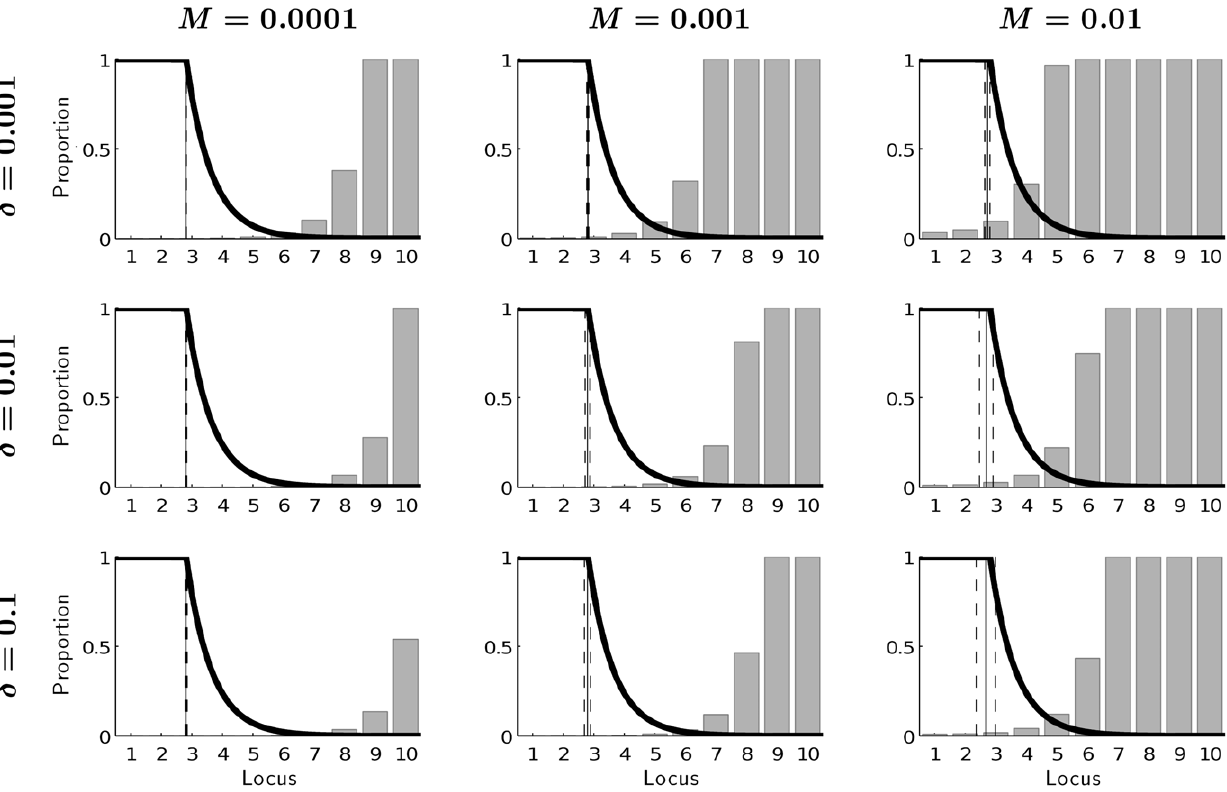
Figure 3. Equlibrium frequencies of mutations at different loci for background mortality m e =0.01 and no effect of mutations on production rate ( l =0) under different mutation rates M and different effects of mutations on mortality d . The vertical lines represent mean age at maturity (solid) with standard deviation (dashed). The thick solid line captures the fraction of remaining reproduction, which is proportional to Hamilton’s force of selection.